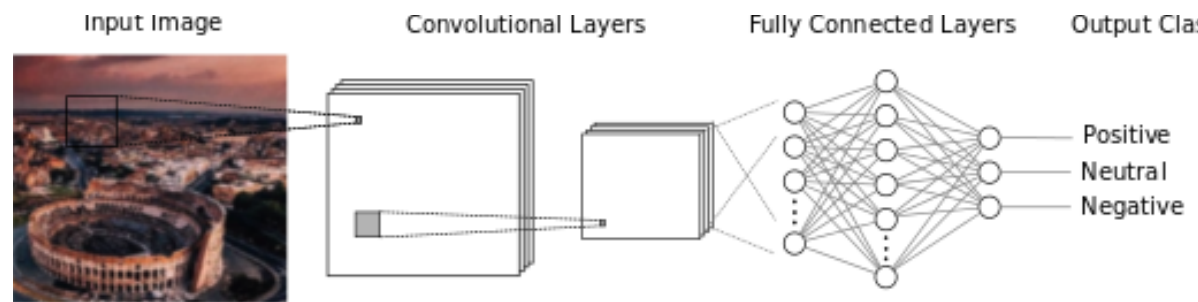
Figure 1. DCNNs for sentiment